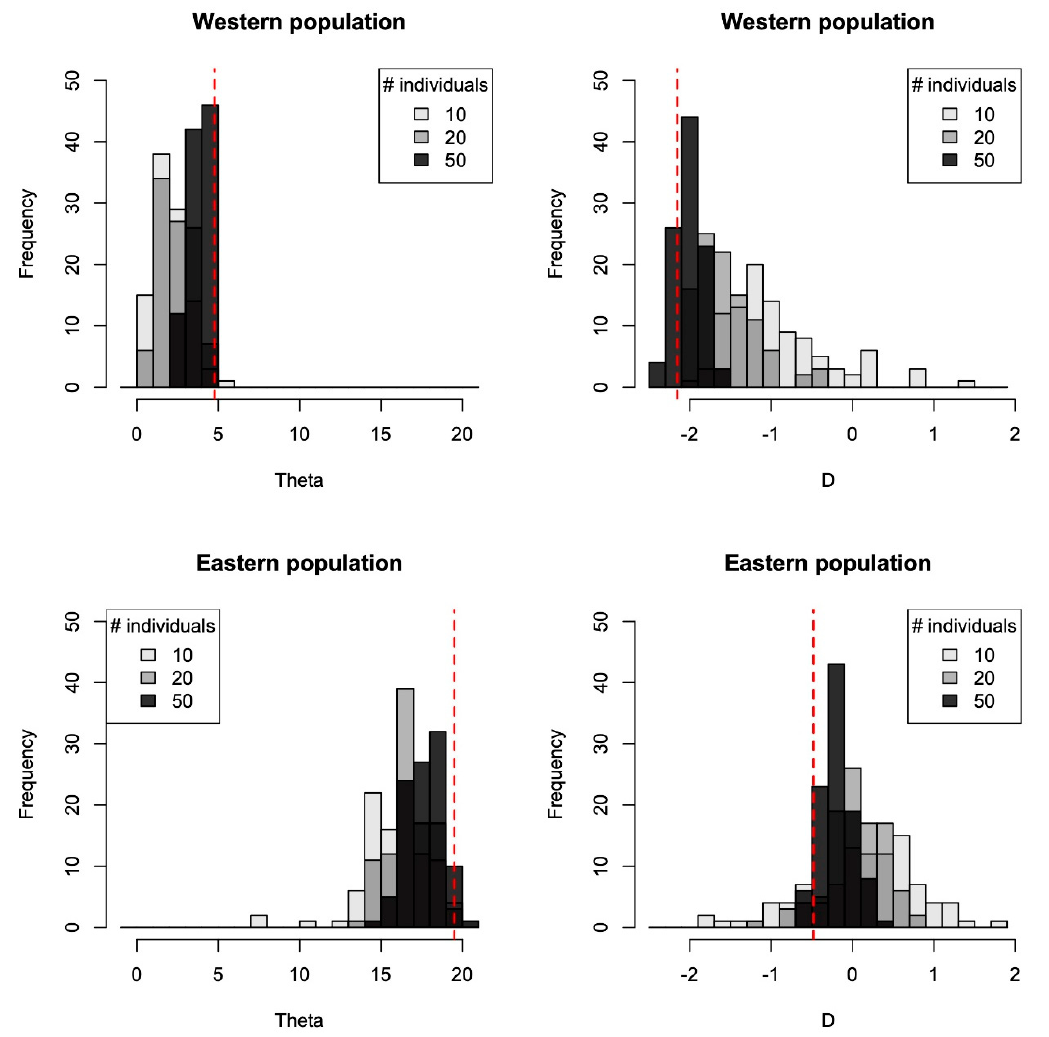
Figure 5. The values of θ and Tajima’s D calculated for western and eastern populations of Psolodesmus mandarinus . The red dashed lines indicate the values estimated from the original dataset (86 individuals from western and 100 individuals from eastern populations).